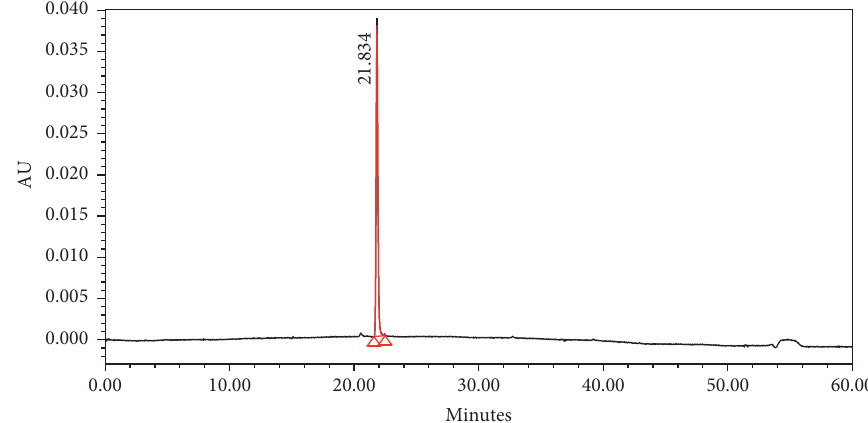
Figure 4: Normal-phase HPLC profile of vitexin (standard) identified at a retention time of 21.834min.